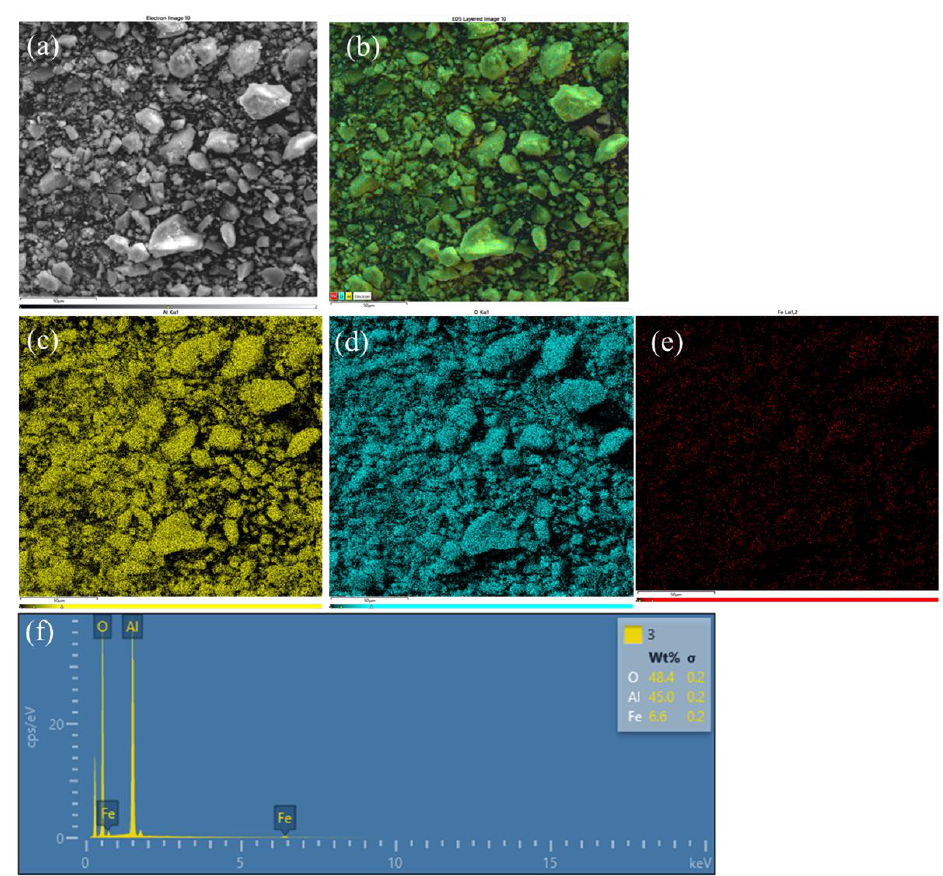
Figure 2. EDX spectrum and elemental mapping for Al-Fe 10 -3: ( a ) SEM image, ( b ) layered elemental mapping, ( c ) aluminum distribution, ( d ) oxygen distribution, ( e ) iron distribution, and ( f ) the corresponding EDX spectrum.